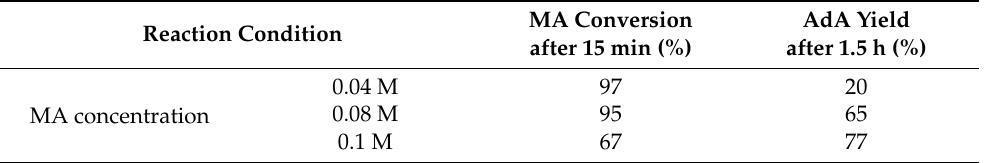
Table 4. Summary of the catalytic results at different substrate concentrations. Reaction conditions: